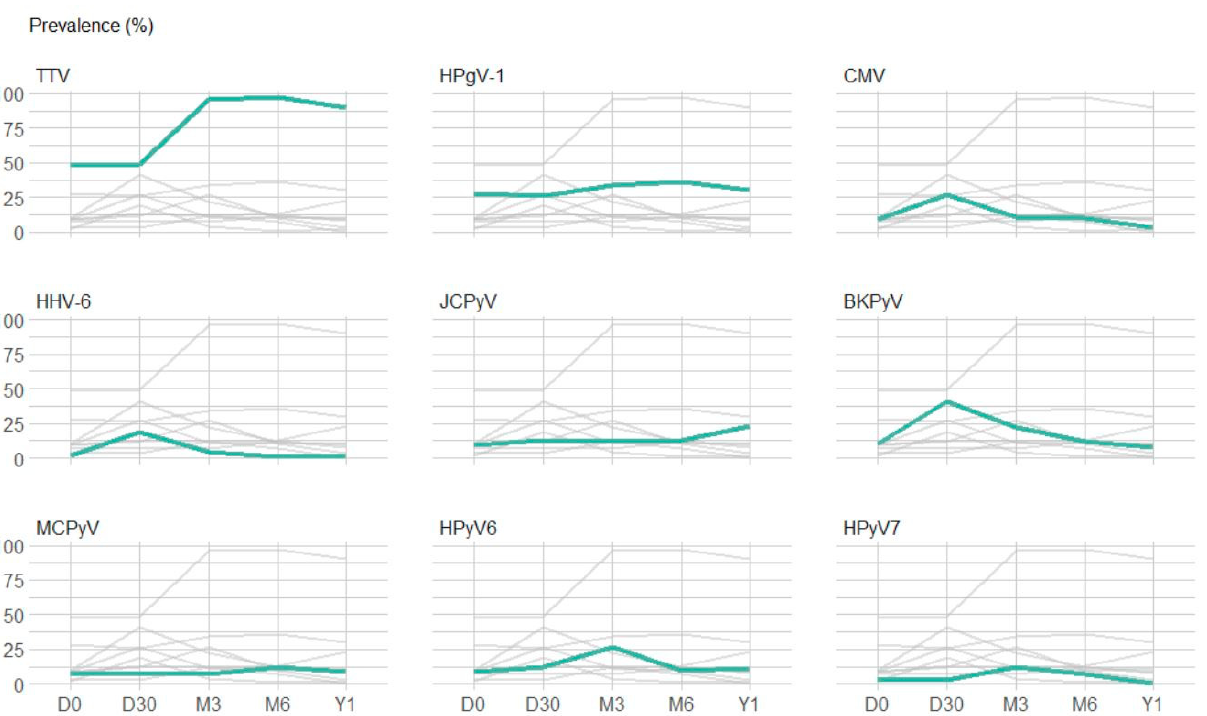
Figure 2. Prevalence of plasma detection of the 9 viruses with a plasma detection prevalence above 10%. The graphs represent the prevalence of the 9 viruses with a prevalence of plasma detection above 10% at least at one time-point after transplantation. For each graph, green lines highlight the prevalence of plasma detection of one specific virus and grey lines represent the prevalence of plasma detection of the other 8 viruses. Abbreviations: TTV: torque teno virus; HPgV-1: human pegivirus 1; HPyV6: human polyomavirus 6; BKPyV: BK polyomavirus; JCPyV: JC polyomavirus; HPyV7: human polyomavirus 7; CMV: cytomegalovirus; MCPyV: Merkel cell polyomavirus; HHV-6: human herpesvirus 6.